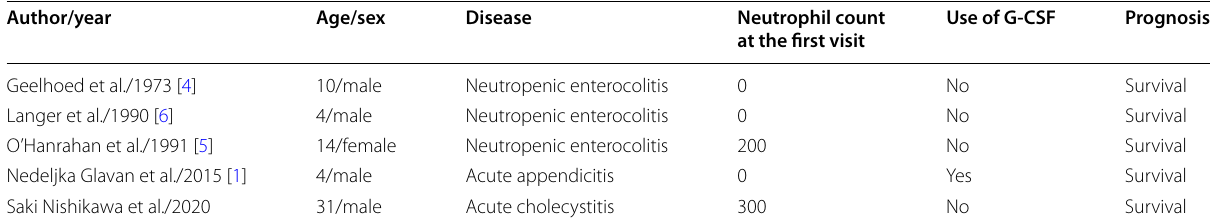
Table 1 Summary of abdominal surgeries performed in emergency settings for patients with cyclic